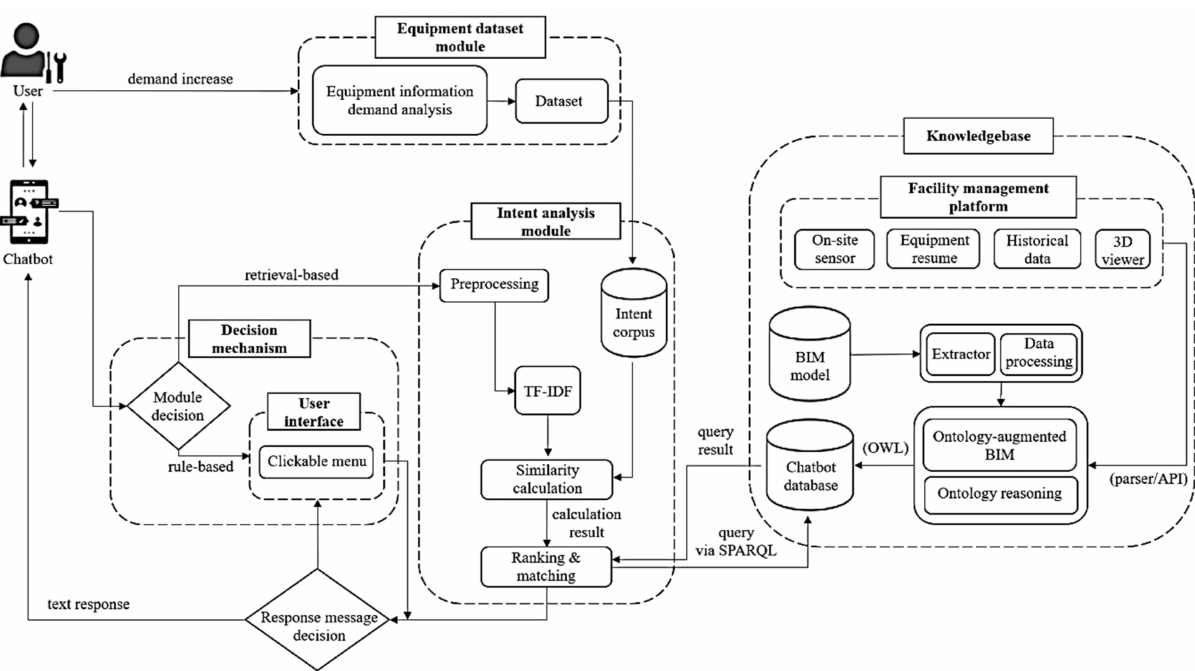
Figure 1. Conversation-based system